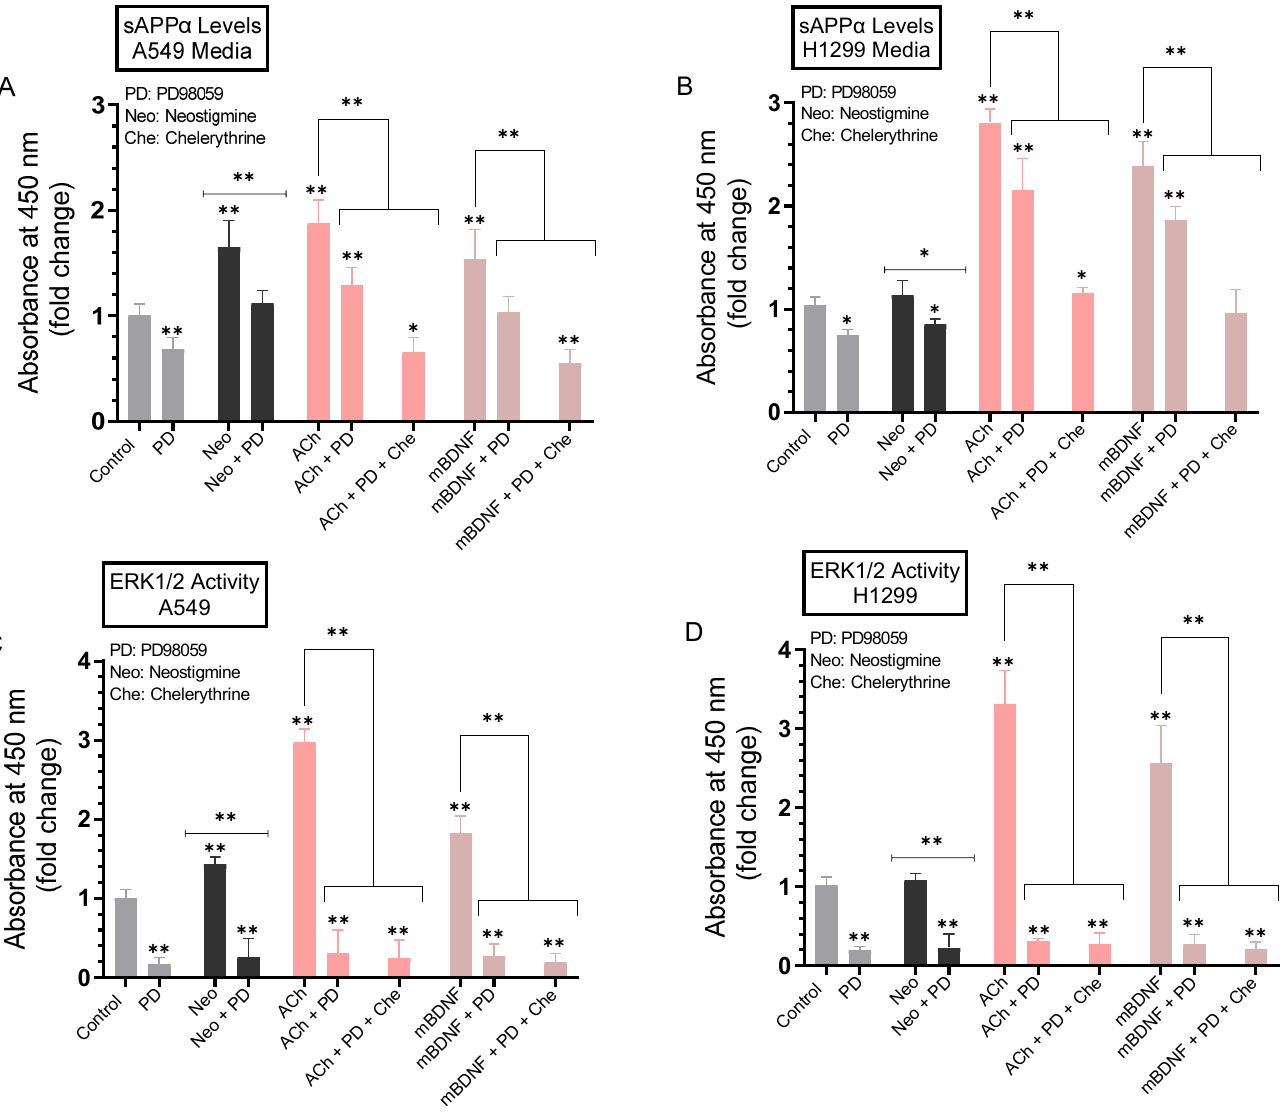
Figure 8. Blocking ERK1/2 and PKC activities using PD98059 and chelerythrine resulted in a larger decrease in sAPP α levels in A549 and H1299 cell media. Cells (0.2 × 10 5 ) were grown in 10% FBS-supplemented media for 24h. The following day, the cell monolayers were incubated in serum-free media for 24h, then treated for 72h with the ERK1/2 inhibitor (PD98059, 50 μ M) PKC inhibitor (chelerythrine, 7.5 µ M), neostigmine (Neo, 50 µ M), ACh (100 nM), mBDNF (5 nM), or in combination. Levels of sAPP α released into the culture media of A549 ( A ) and H1299 ( B ) cells during the 3-day incubation period were measured as described in the Methods section on the same amount of protein (3 μ L of 600 μ g/mL total protein) of each sample. ERK1/2 activity was measured in A549 (C) and H1299 (D) cells as described in the Methods section. Data from five independent assays, each carried out in triplicate, were averaged, normalized, and expressed as fold change relative to untreated cells (control) using the GraphPad 9.4.1 software. The graphs summarize the results expressed as means ± SD (n = 5). Asterisks (*) indicate a statistically significant difference from the corresponding control of each cell line while absence of asterisks indicates no significance, Mann-Whitney test. Statistical differences between different groups were analyzed by an ordinary one-way analysis of variance (ANOVA) followed by Tukey’s post-hoc multiple comparison test. *p<0.05, **p<0.0l.